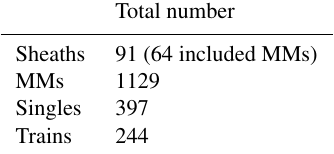
Figure 2. Division of detected MMs to individual ones and the ones in MM trains and the division of MM trains according to the number of MMs in them.